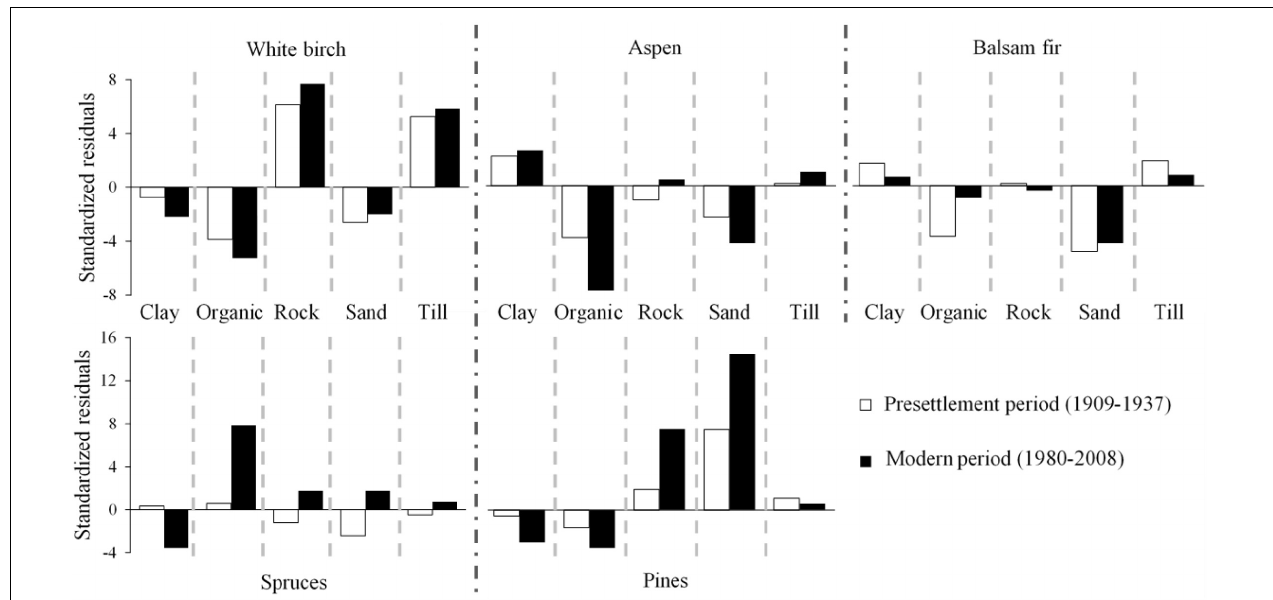
FIGURE 3 | Corrected standardized residuals by type of surficial deposits during pre-settlement (1909–1937) and modern (1980–2008) periods, for taxa that presented a significant ( α = 0.05) G statistic. A positive value indicates an over-representation of a taxon relative to a random distribution. A negative value indicates an under-representation. Y axes scale differ between the graphs. Aspen refers to trembling aspen. Spruces and Pines are grouped to genus level.